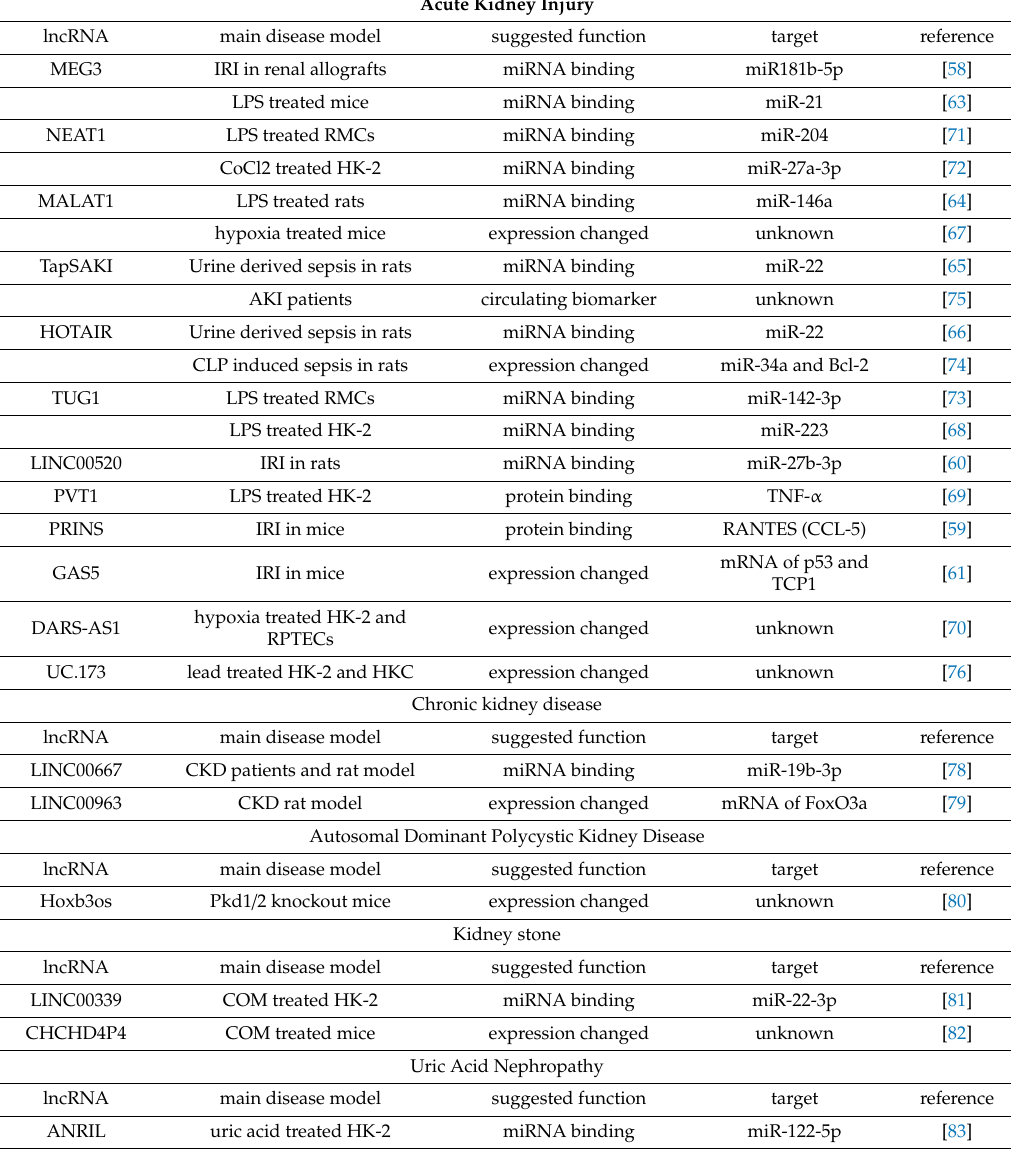
Table 2. LncRNAs involved in tubulointerstitial